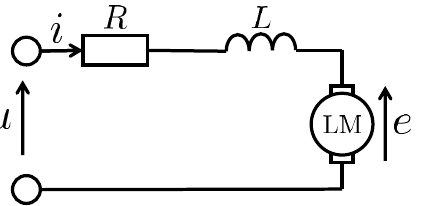
Figure 7. Circuit diagram of armature coil-equipped VCM.